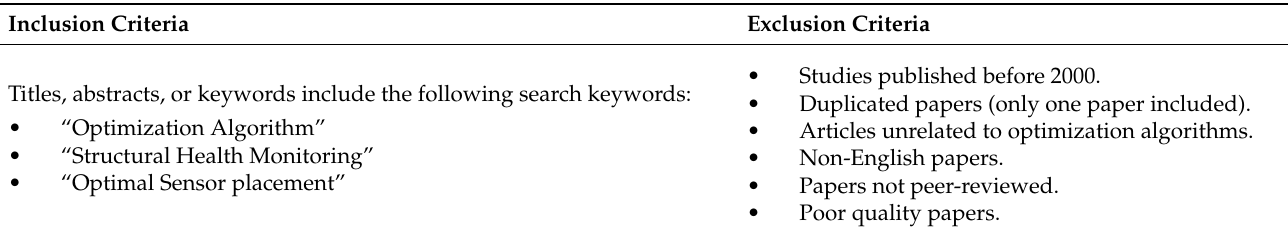
Table 5. Exclusion and inclusion criteria in selecting the reviewed